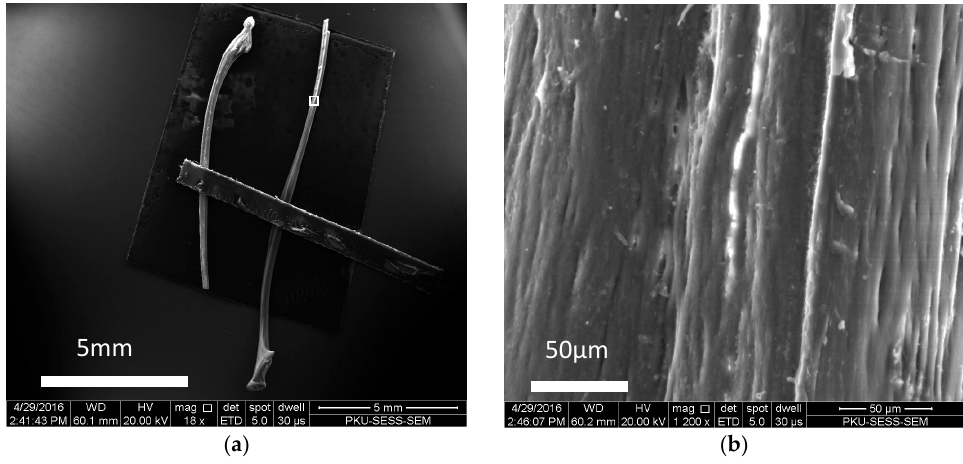
Figure 1. ESEM images of hard tissues of Cololabis saira . ( a ) two bones with sizes of 9.8 × 0.33 mm and 13.7 × 0.38 mm, note: fixing matter is overlying the two bones; ( b ) a closer look (×1200) at the part within the white square of ( a ). Table 2. EDS data (atom %) of HAP in bones of Cololabis saira .